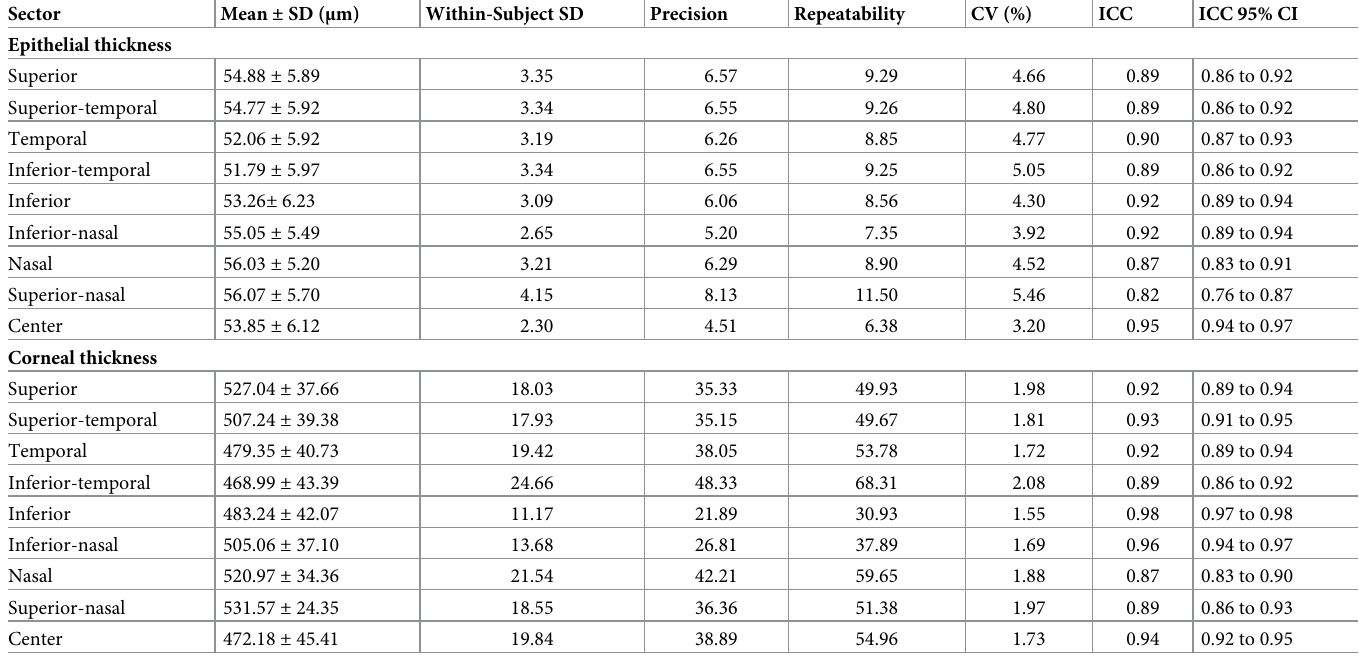
Table 2. Measurements in Group A: Eyes without a history of